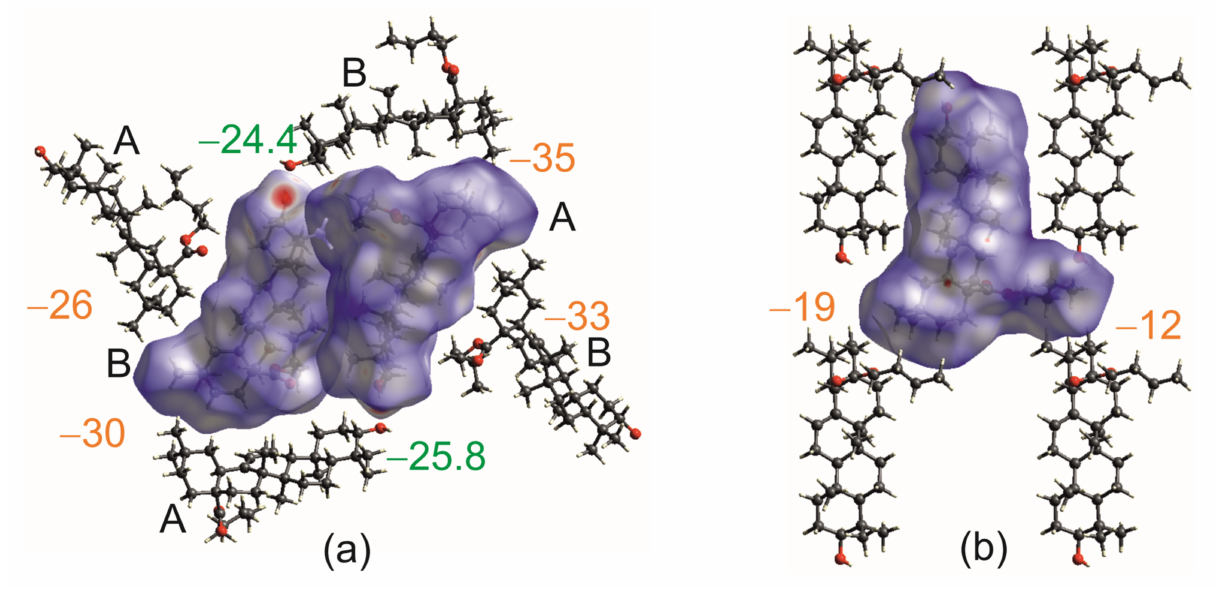
Figure 9. The energy of the ( a ) O-H ··· O hydrogen bonds (green) and side interaction (orange) of molecules from dimer to molecules from surrounding ribbons in R 3-but-OA and ( b ) interlayer interaction in P 2 1 -but-OA : The energy values color match the color in Table S4. For selected molecules, Hirshfeld surfaces mapped with d norm are shown. For O-H ··· O hydrogen bonds, the given values were calculated with ω B97M-V/def2-TZVPD